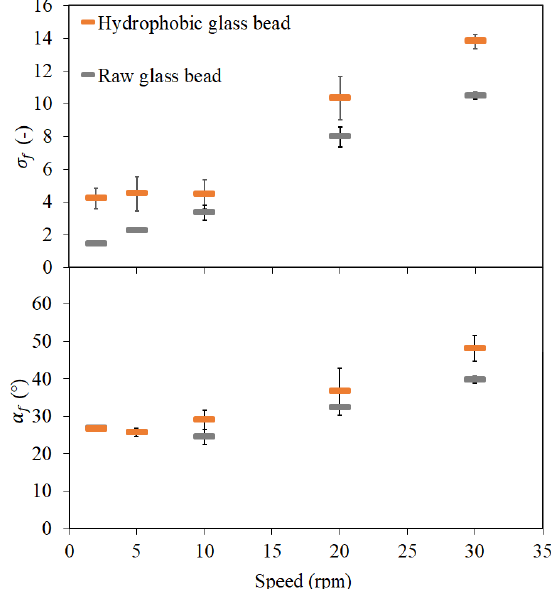
Figure 5. Evolution of the flowing angle and cohesion of raw and hydrophobic glass beads under di ff erent rotational speed with the measurements performed by GranuDrum. The humidity and temperature range are 37-44 % and 22 ◦ C,